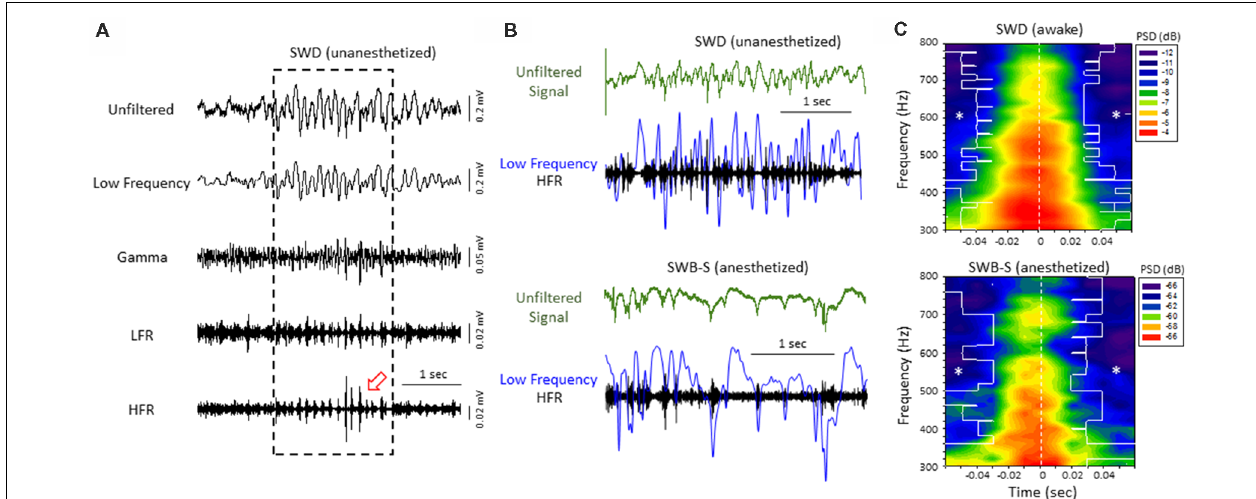
FIGURE 3 | High-frequency ripple (HFR) activity recorded from the iS1 cortex was locked to high-amplitude spike deflections observed in the low frequency band of both awake and anesthetized animals. (A) Example of a spontaneous SWD (awake) from the iS1 cortex and corresponding HFOs. Each signal was digitally filtered into spectral bandwidths for comparison as defined in Figure 1 . Strong wax-and-wane amplitude oscillations (red arrow head) were commonly observed across the HFR spectrum locked to the large amplitude spike deflections of the SWD. (B) Representative traces from freeze lesion animals indicating that the oscillatory amplitude changes observed in the HFR band were locked to the spike-and-wave pattern of the low frequency band during both spontaneous SWDs (upper panel) and spike-wave burst-suppression (SWB-S) events (lower panel). In each example an overlay of the low frequency (blue trace) and HFR (black trace) bands are presented below each unfiltered trace (green) for comparison. (C) Average perievent spectrograms indicating that the increases in PSD within the HFR frequency band were centered on the “spike” of the spike-and-wave pattern that occurred during either SWDs (upper panel, n = 5) or B-S events (lower panel, n = 6). SWDs were recorded from the iS1 region of awake animals while the B-S events shown were recorded from the supragranular layer of the iS1 region of anesthetized animals. ∗ P < 0.05 compared to PSD values at time 0 for each frequency bin (Holm-Sidak post hoc analysis).